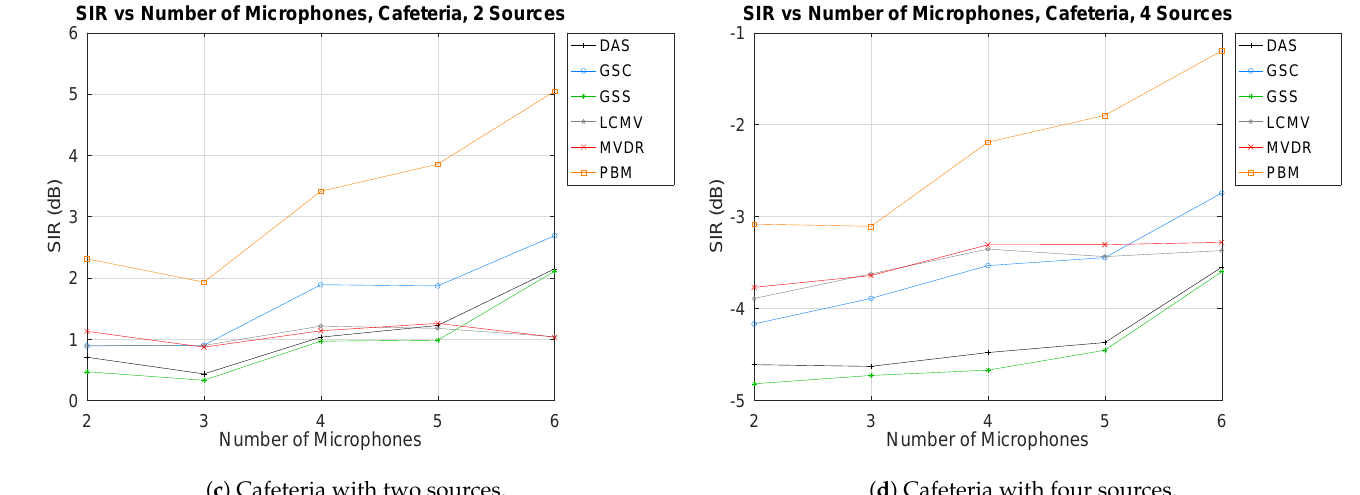
Figure 6. SIR vs. Number of